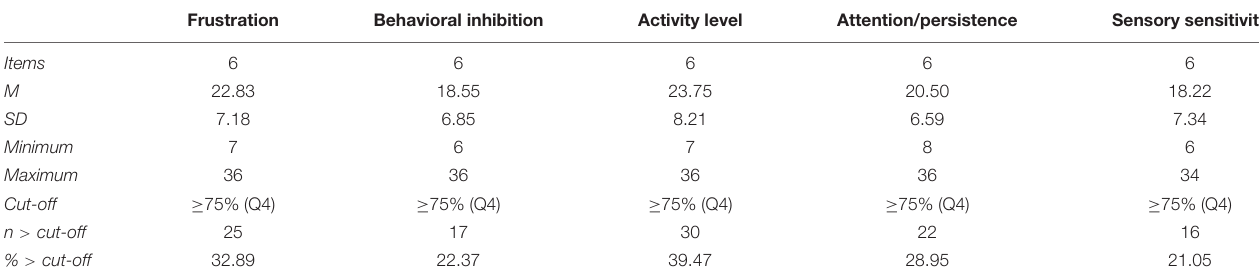
TABLE 3 | Descriptive statistics of ICTI ( n =